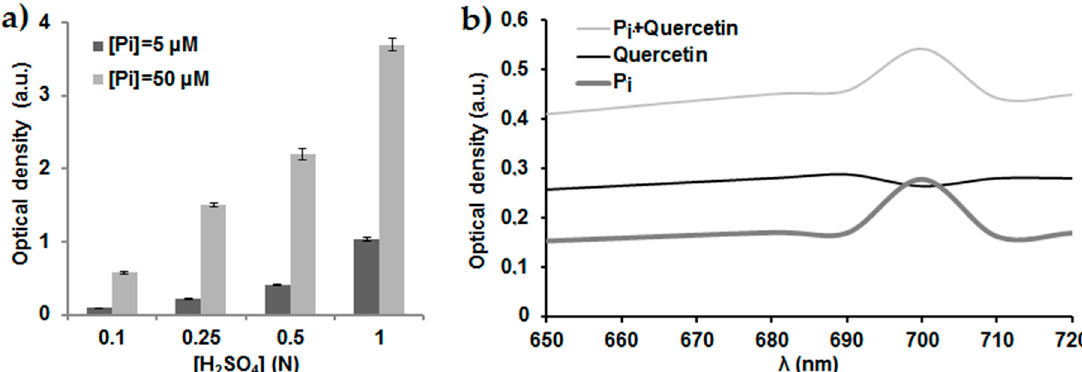
Figure 1. ( a ) Optimization of H 2 SO 4 concentration for the P i dosage. Standard P i solutions of 5 μ M and 50 μ M prepared in tris-HCl buffer (pH = 8.5; 50 mM). Incubation time: 10 min. λ = 700 nm. Error bars show the standard deviation obtained from experiments done in triplicate. ( b ) Spectra showing the OD of standard solutions of P i , quercetin and a mixture of P i and quercetin. P i = 5 μ M; Quercetin = 30 μ M.